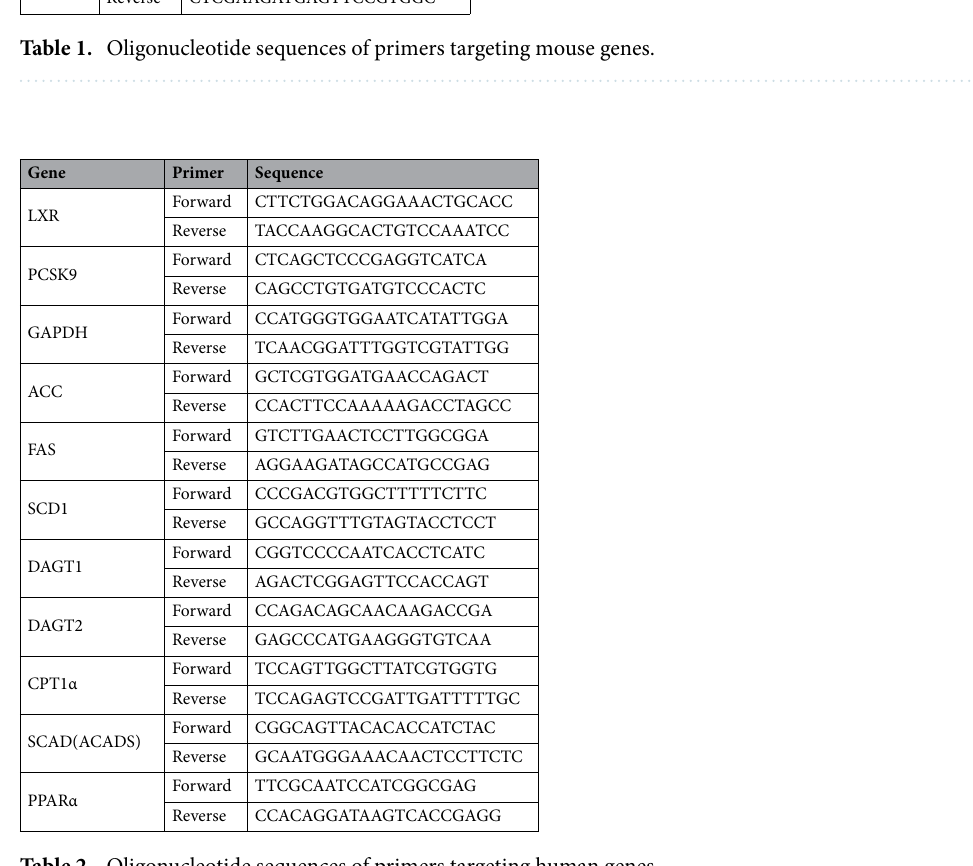
Table 2. Oligonucleotide sequences of primers targeting human